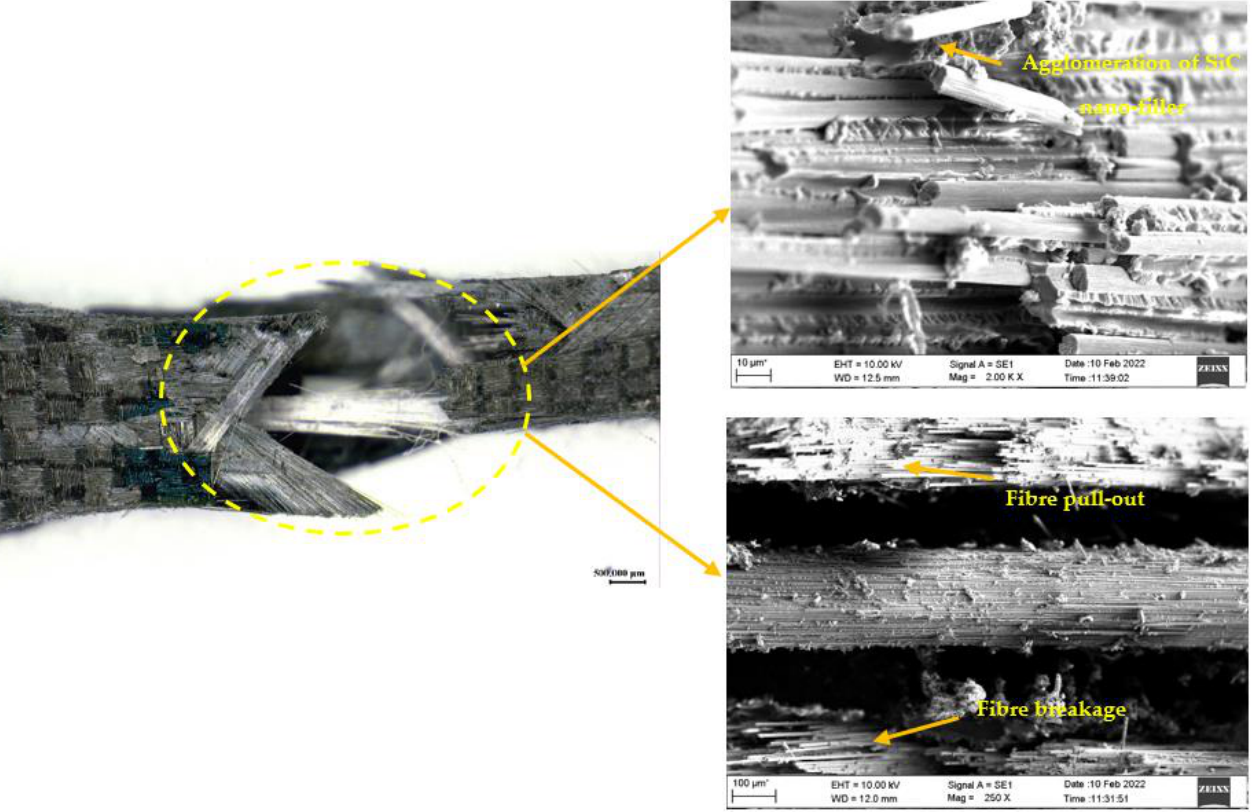
Figure 11. SEM images of tensile failure specimens of hybrid SiC nano-composites at 1.25 wt.%.